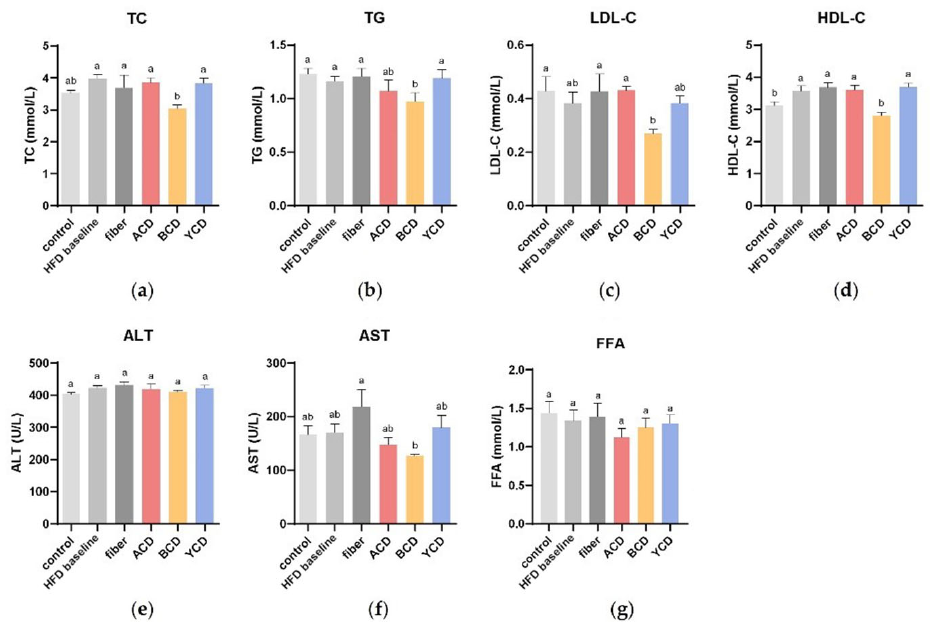
Figure 4. β‐ CD supplementation improved blood lipid parameters and did not cause damage to hepatocytes. Serum concentrations of ( a ) TC; ( b ) TG; ( c ) LDL-C; ( d ) HDL-C; and ( g ) FFA. Serum hepatocytes. Serum concentrations of ( a ) TC; ( b ) TG; ( c ) LDL ‐ C; ( d ) HDL ‐ C; and ( g ) FFA. Serum ( e ) ( e ) ALT; ( f ) AST activities. n = 6. Control, low-fat diet; HFD baseline, high-fat diet without cellulose; ALT; ( f ) AST activities. n = 6. Control, low ‐ fat diet; HFD baseline, high ‐ fat diet without cellulose; fiber, high-fat diet; ACD, high-fat diet that replaced α -CD with cellulose; BCD, high-fat diet that fiber, high ‐ fat diet; ACD, high ‐ fat diet that replaced α‐ CD with cellulose; BCD, high ‐ fat diet that replaced β -CD with cellulose; YCD, high-fat diet that replaced γ -CD with cellulose. Data are replaced β‐ CD with cellulose; YCD, high ‐ fat diet that replaced γ‐ CD with cellulose. Data are ex ‐ expressed as means ± SEM. Values not sharing a common superscript differ significantly among pressed as means ±SEM. Values not sharing a common superscript differ significantly among groups ( p < 0.05, groups ( p < 0.05, ANOVA).